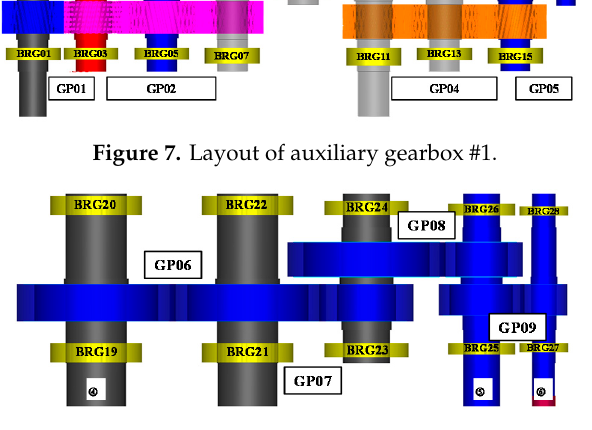
Figure 8. Layout of auxiliary gearbox #2.